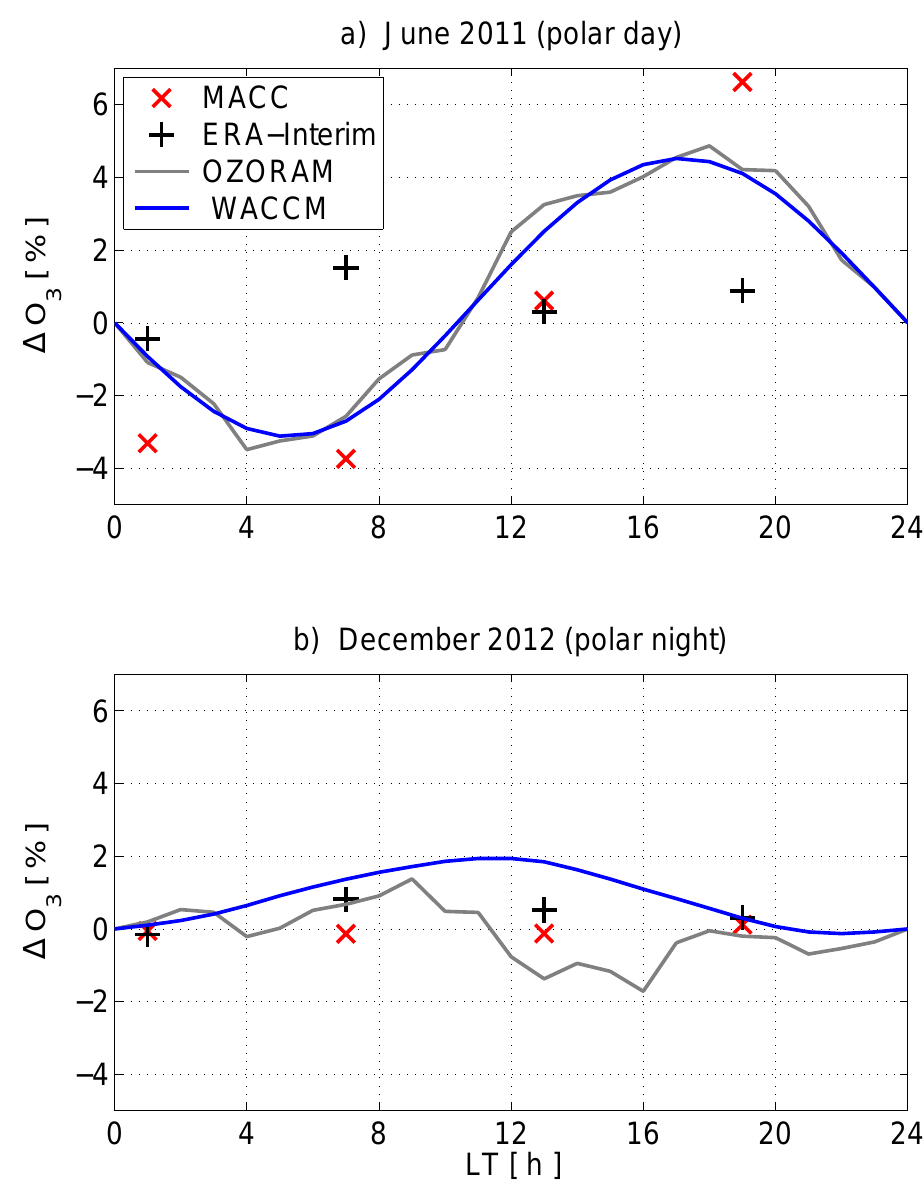
Figure 6. Relative diurnal variation in ozone as function of local time (LT) for MACC reanalysis (red markers), ERA-Interim (black markers), WACCM (blue line), and OZORAM (grey line) at 5 hPa (38 km) over Ny-Ålesund, Svalbard (78.9 ◦ N, 11.9 ◦ E). The figure shows the relative diurnal variation according to Equation (1) for a summer ( a ) and winter ( b ) month. The SMILES climatology does not cover the high latitude of Ny-Ålesund. The summer period is taken from 2011 due to technical problems of the instrument in summer